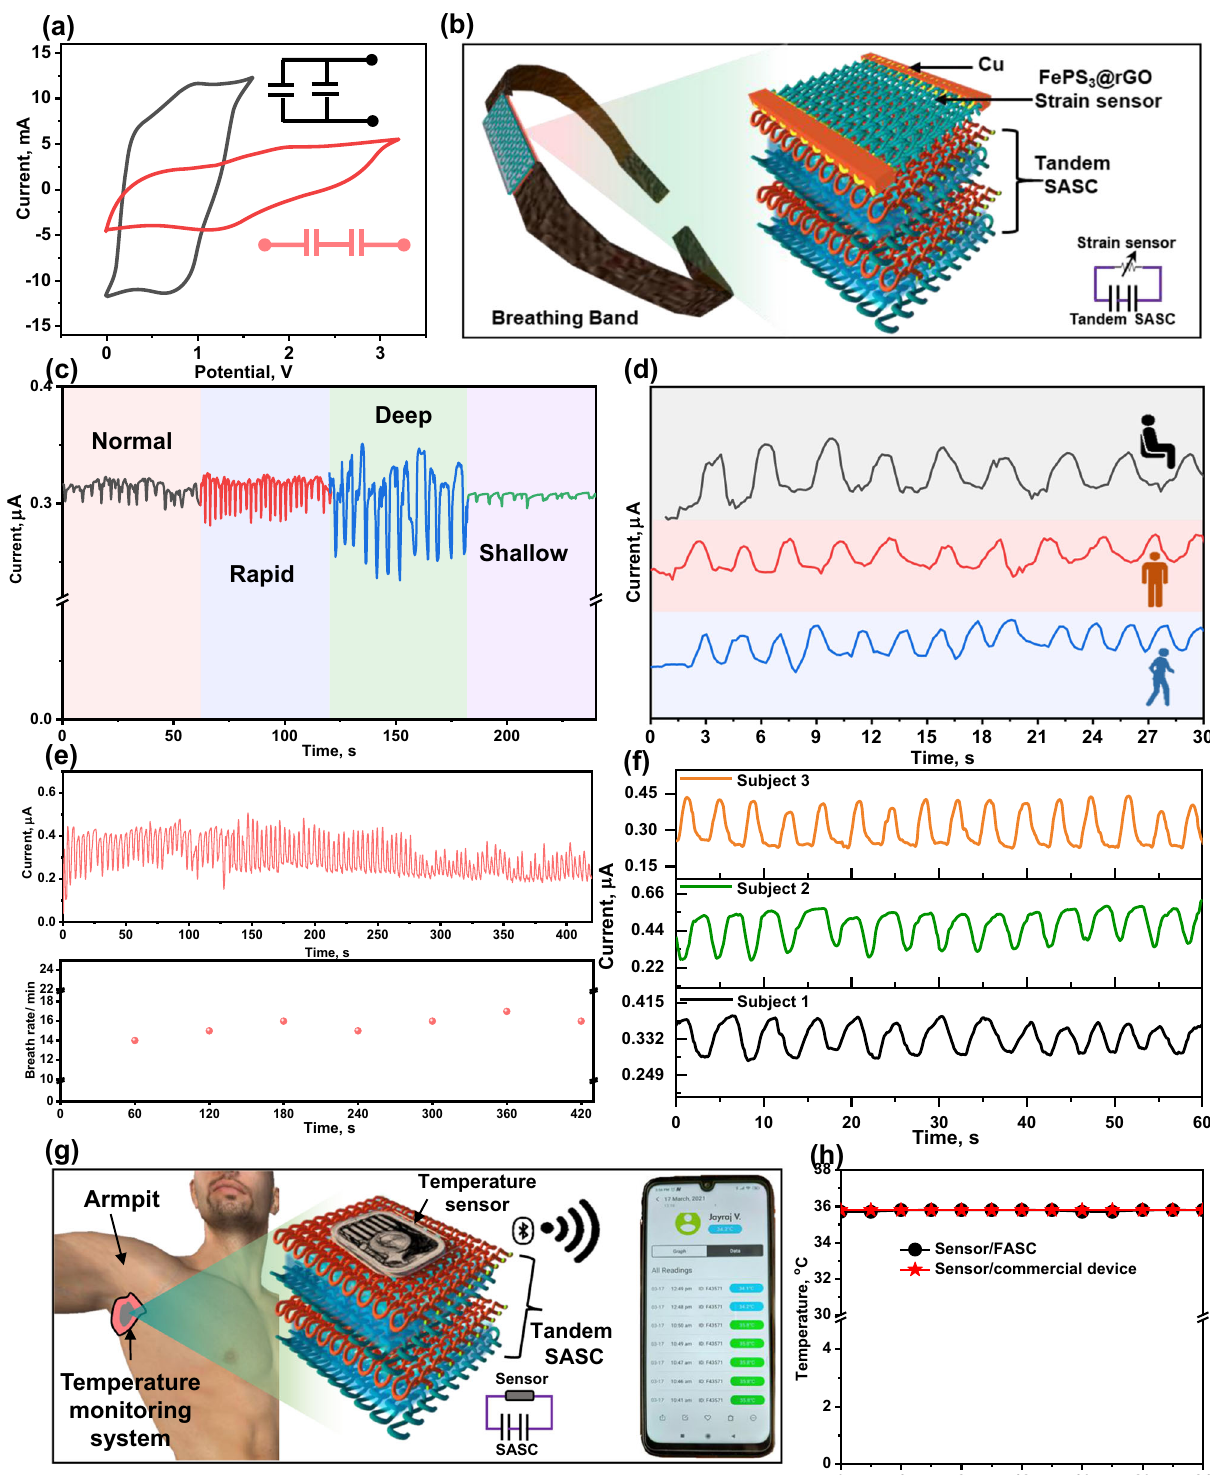
Fig. 5 Remotely monitoring physiological parameters of human. a CV pro fi le of the SASC connected in parallel and in series. b Schematic illustration of breathing band containing integrated FePS 3 @rGO strain sensor with tandem SASC. c Breathing signals recorded at normal, rapid, deep, and shallow breathings. d Breathing pattern as a function of activity such as sitting, walking, and running. e Multiple breathing cycles and corresponding breathing rate per minute. f Breathing rate of three volunteer subjects. g Integrated temperature sensor with tandem Ti 3 C 2 /FePS 3 @rGO SASC to monitor the user ’ s body temperature and wirelessly transmit data to the mobile phone. h Real temperature as a function of time as measured by the integrated temperature sensor operated by Ti 3 C 2 /FePS 3 @rGO SASC and bias of 1.5